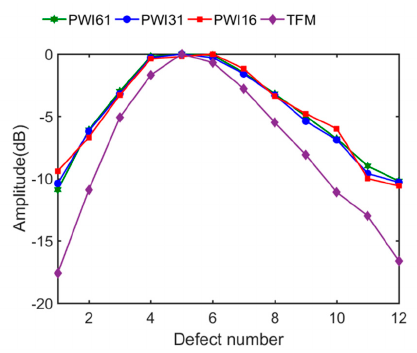
Figure 11. Amplitude attenuation on each defect in PWI imaging with three angle numbers and TFM imaging.